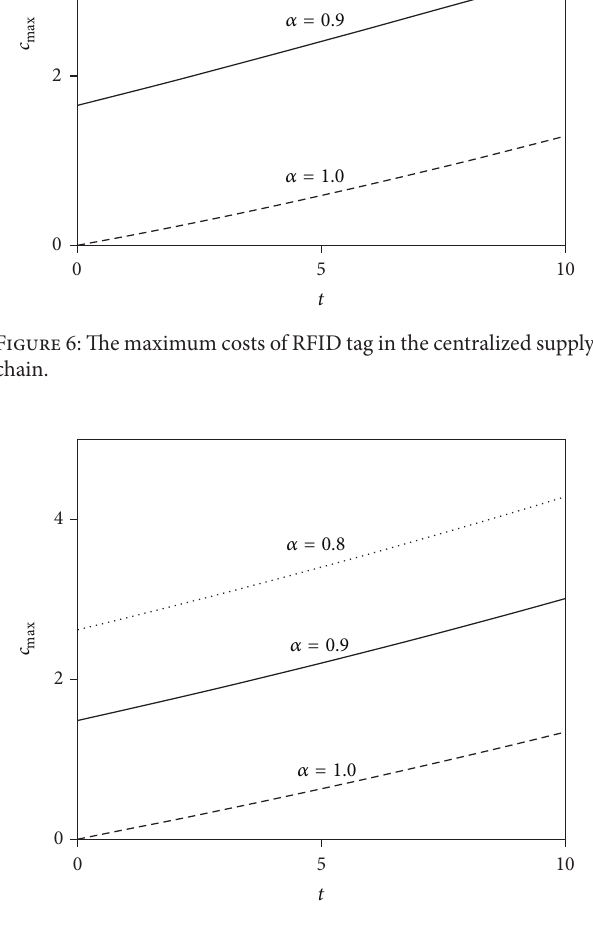
Figure 7: The maximum costs of RFID tag in the decentralized supply